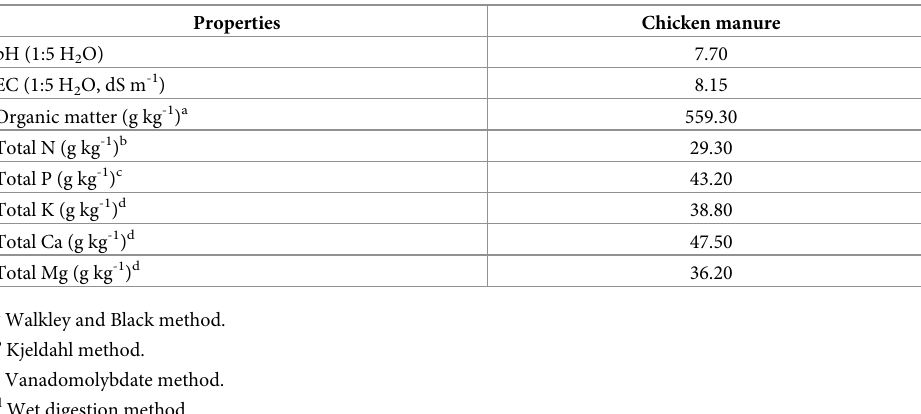
Table 1. Properties of chicken manure used in the experiment. Properties Chicken manure